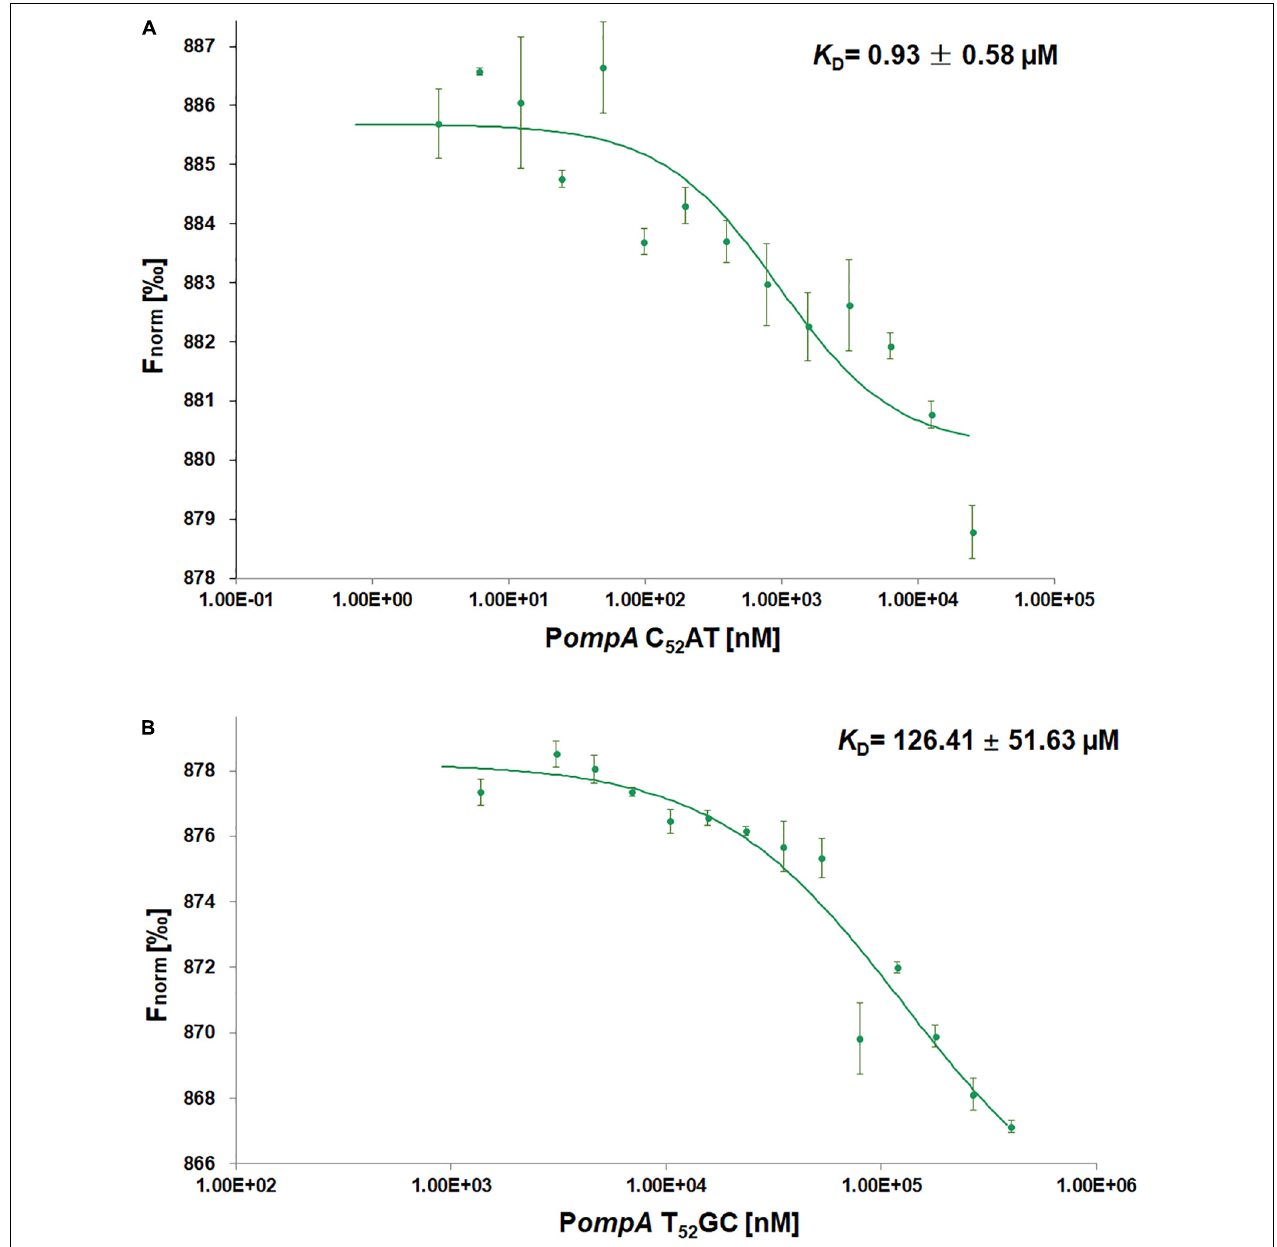
FIGURE 3 | Small protein B protein interacts with the P ompA by microscale thermophoresis (MST) assays. (A,B) Dose Response Fit of SmpB protein with P ompA C 52 AT and P ompA T 52 GC. Fnorm values of Y-axis in the dose response plot are calculated from the ratio of normalized fluorescence F 0 /F 1 , where F 0 corresponds to the normalized fluorescence prior to MST activation. F 1 is determined after an optimal MST power-dependent time interval which yields the best signal-to-noise ratio. The X-axis is the different concentration of P ompA after successive dilution. The initial concentrations of P ompA C 52 AT (native ompA promoter) and P ompA T 52 GC (mutant) were, respectively, 25 and 400 µ M in reaction buffer and the fluorescence molecules SmpB labeled by Monolith His-tag Labeling Kit RED-tris-NTA 2nd Generation was 25 nM in the buffer. MST experiments were performed in Phosphate buffered saline-Tween (PBS-T) buffer (2 mM KH 2 PO 4 , 8 mM Na 2 HPO 4 350 mM NaCl, 0.6 mM DTT, 0.05% Tween 20, pH 7.4) with 40% MST-Power, 60%